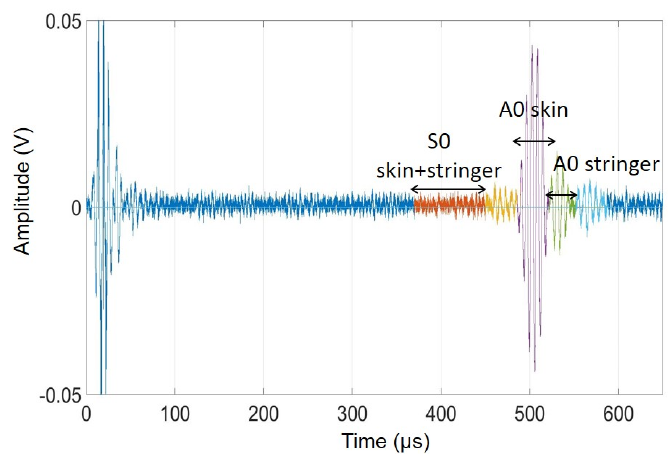
Figure 8. Typical RF waveform measured by the air-coupled pitch–catch prototype from Test Panel 3.